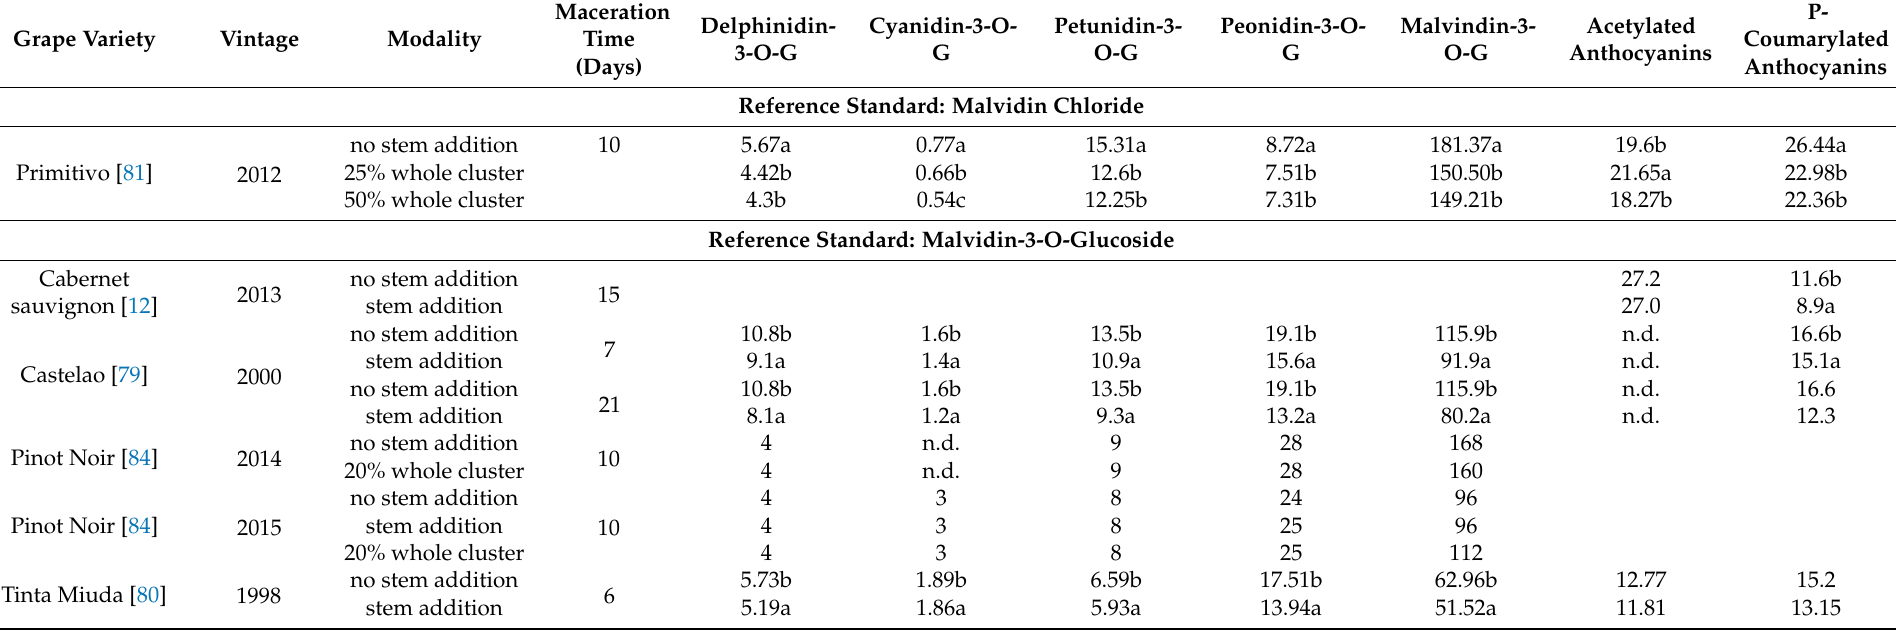
Table 20. Impact of stems during winemaking on individual anthocyanin content (mg/L) (for each study, different letters indicate significant statistical differences).